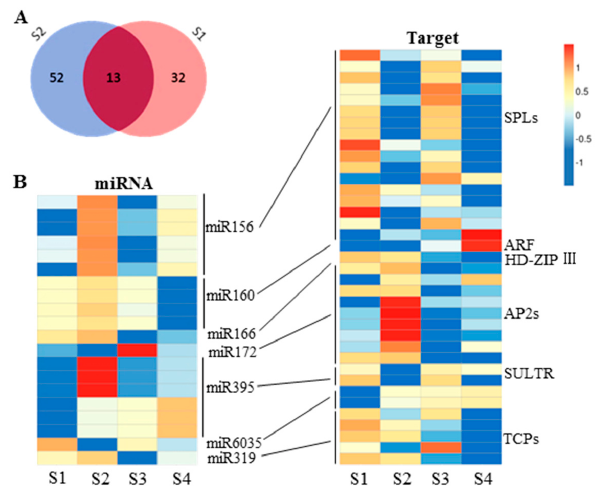
Figure 7. Number of differentially expressed miRNAs and the expression profile of miRNA-targets. ( A ) The number of differentially expressed miRNAs detected between 6098B and Purler at bolting (blue), early flowering (light pink), and both (dark pink) developmental stages. ( B ) The heat map of differentially expressed miRNAs and targets showing greater than 2-fold change between 6098B (S1, S3) and Purler (S2, S4) at bolting or early flowering. SPL (SQUAMOSA promoter binding protein-like), ARF (auxin response factor), HD-ZIP III (Homeodomain leucine zipper III), AP2 (APETALA2), SULTR (sulfate transporter), TCP (TEOSINTE-BRANCHED/CYCLOIDEA/PCF). Color key represents log2 transformed FPKM values, from low (blue) to high (red)